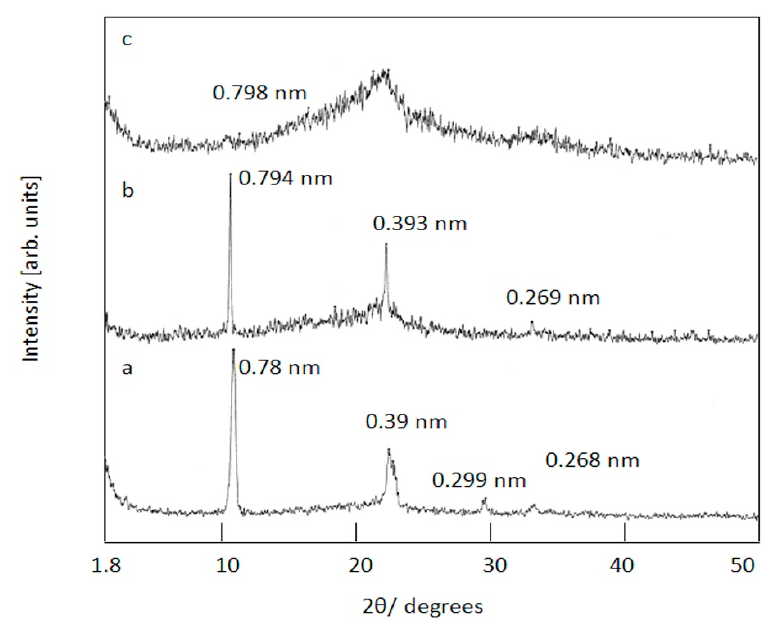
Figure 5. X-ray diffraction of ( a ) CSHDS, ( b ) CSLDH-1, and ( c ) CSLDH-2.